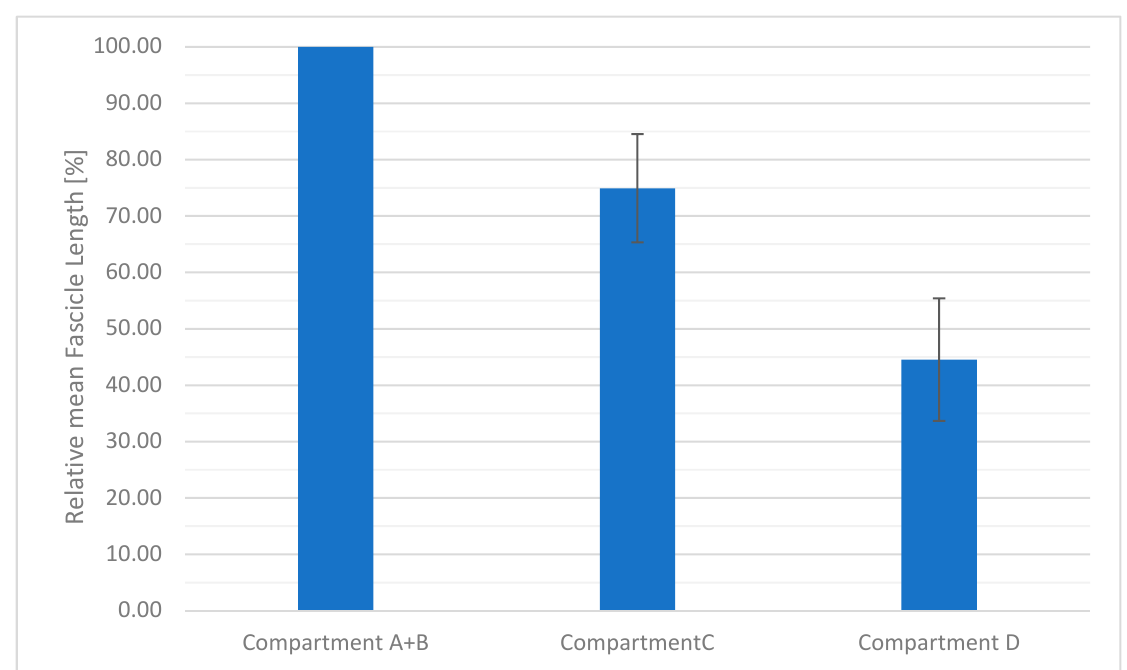
Figure 5. This diagram shows the relative mean fascicle lengths (%) of all animals for cranial (compartment A + B ), middle (compartment C ) and caudal (compartment D ) of the LG. Fascicle lengths decrease from cranial to caudal. Fascicle length of compartment A + B (longest fascicle length) was set to 100%.